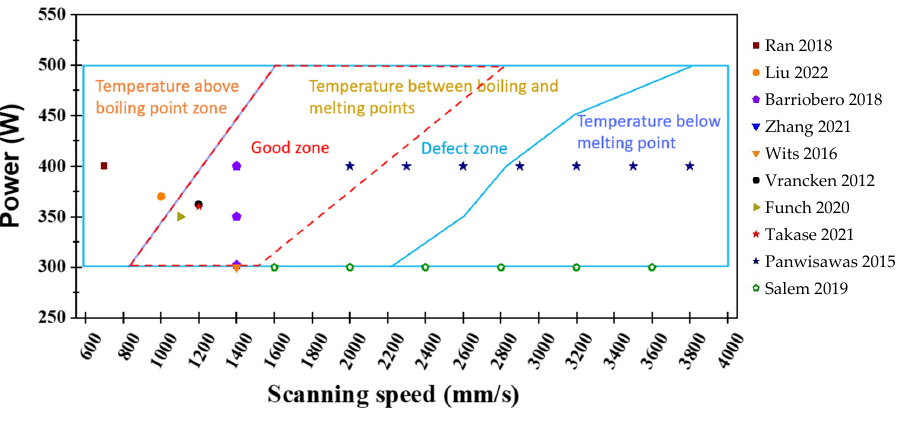
Figure 12. Comparison of predicted process parameter map with experiments from literature reports [41,45–53.]